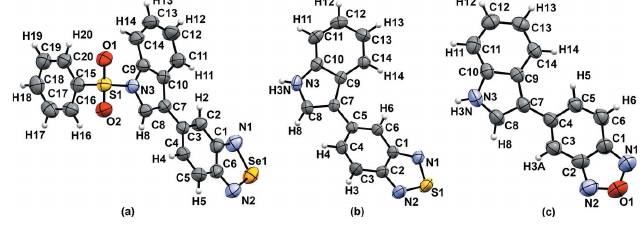
Figure 2 Ellipsoid plots with atom labeling for ( a ) p-bSe ( b ) bS and ( c ) bO. Displacement ellipsoids are drawn at the 50% probability level.